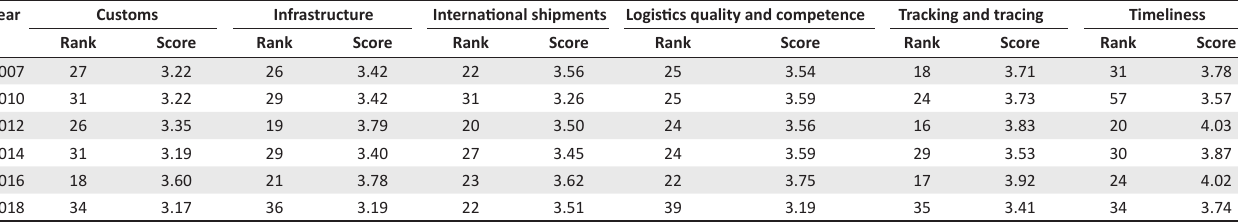
TABLE 2: The scores of South Africa for the six indicators 2007–2018.